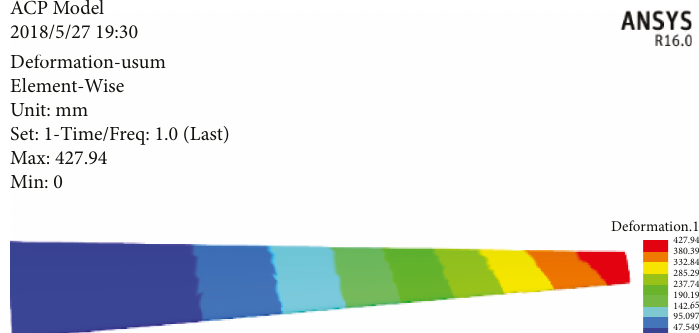
Figure 11: Deformation cloud diagram with the layer sequence being [45/0/90/0/-45]